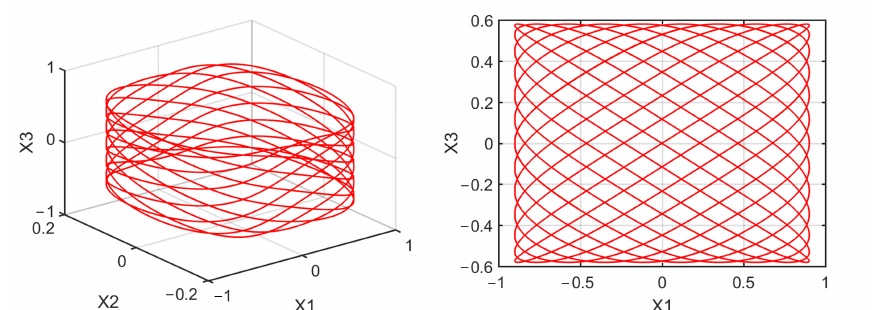
Figure A9. Periodic-11 motion of σ 2 = 4.7810.